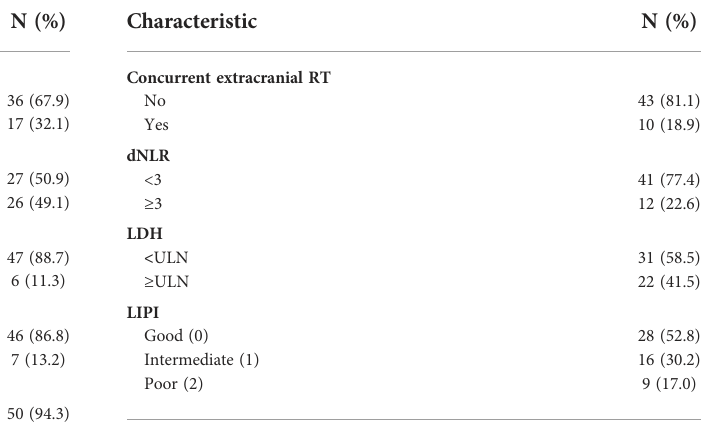
EGFR, epidermal growth factor receptor; ECOG-PS, Eastern Cooperative Oncology Group performance status; PD-L1, programmed death-1 ligand; BMs, brain metastases; RT, radiotherapy; TKI, tyrosine kinase inhibitor; ICI, immune checkpoint inhibitor; dNLR,derivedneutrophil-to-lymphocyteratio;LDH,lactatedehydrogenase;ULN,upper limit of normal; LIPI, immune prognostic